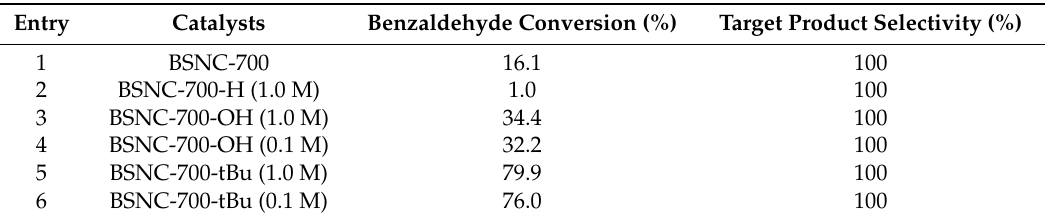
Table 4. Knoevenagel condensation of benzaldehyde with malononitrile by the deprotonation of BSNC-700.